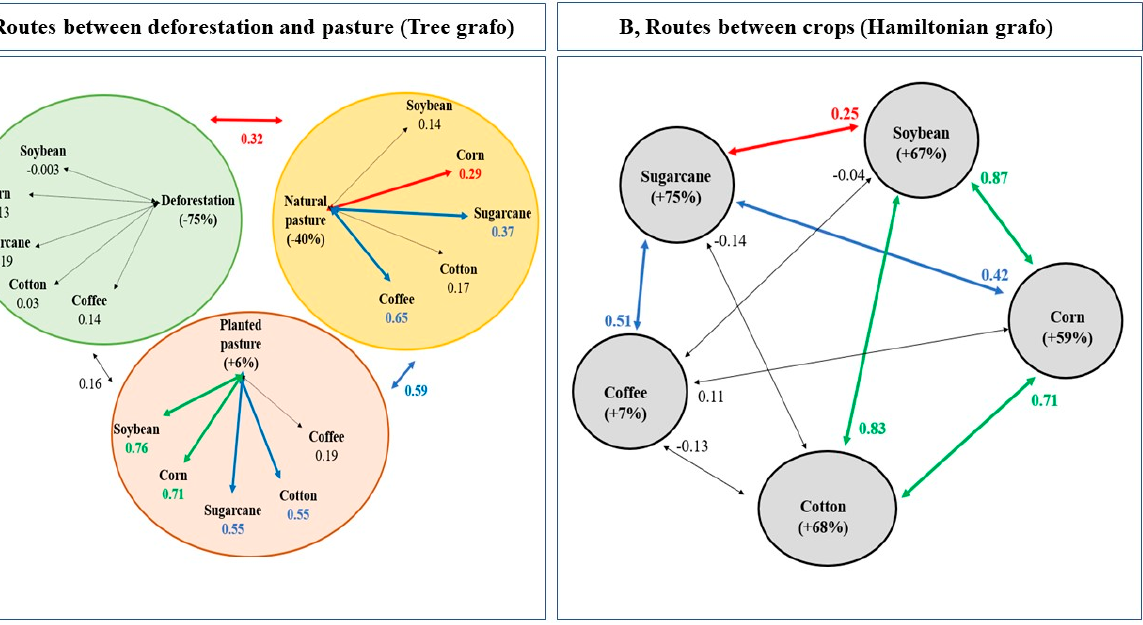
Figure 8. Routes from deforestation and pasture (natural and planted) to crops (( A ) tree grafo, adapted) and the routes between crops (( B ) Hamiltonian cycle). The k-apexes in both route analyses were linearly correlated by the Pearson correlation test ( p < 0.01). The results of correlation coefficient were separated into three level of routes: (i) low level (r-flux: 0–0.33; red), (ii) median level (r-flux: 0.34–0.66; blue), and high level (r-flux: 0.67–1.0; green).